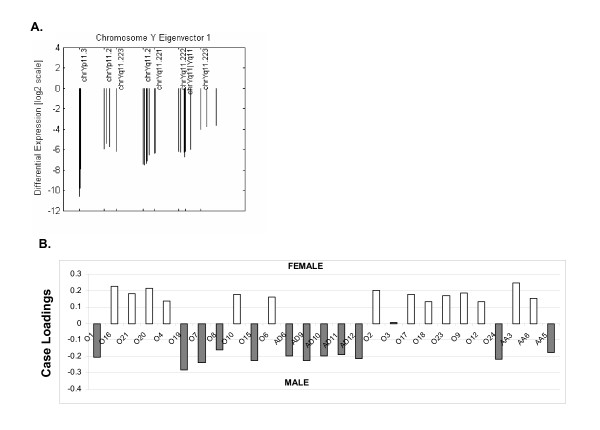
Chr Y Analysis and Sensitivity to Gender. A) The SVD decomposition of Chr.Y alone determined a uniform pattern spanning the entire chromosome. B) Illustration of the corresponding case loadings indicating the amount of expression of the chromosomal pattern expressed by each case. In this convention, positive values indicate loss of expression. Dark bars indicate male cases while white bars indicate female cases. There is an obvious and clear separation between arrays due to gender although a loss of Y expression is detected in tumour tissue for case O3.